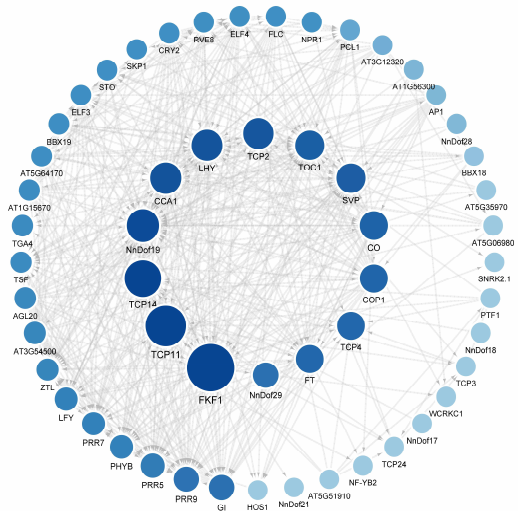
Figure 4. The prediction of a cis-acting element in the 2000 bp promoter upstream of the NnDofs . The main cis-acting elements are marked in the upper right corner.